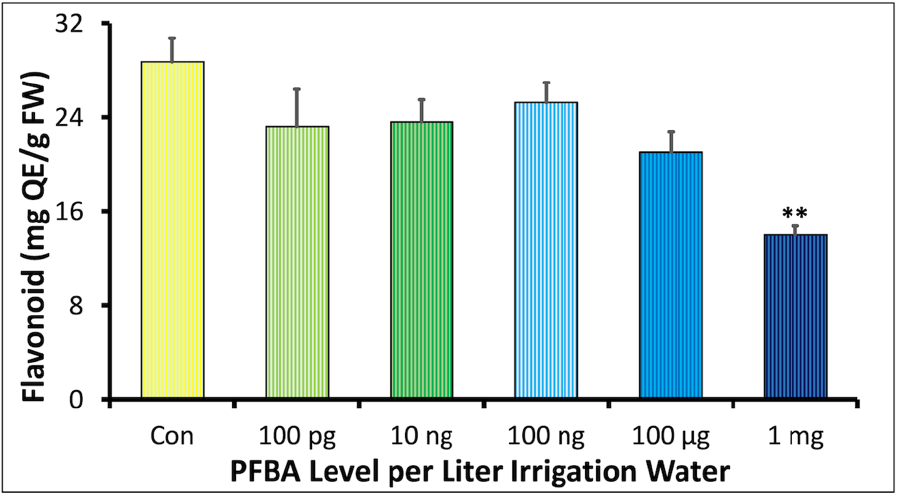
Figure 3. Dose–response relationship between the concentration of PFBA in irrigation water and leaf flavonoid content in soybean plants grown for 5 weeks. The ** symbol indicates significant difference between the treatment and control at p < 0.01, respectively.